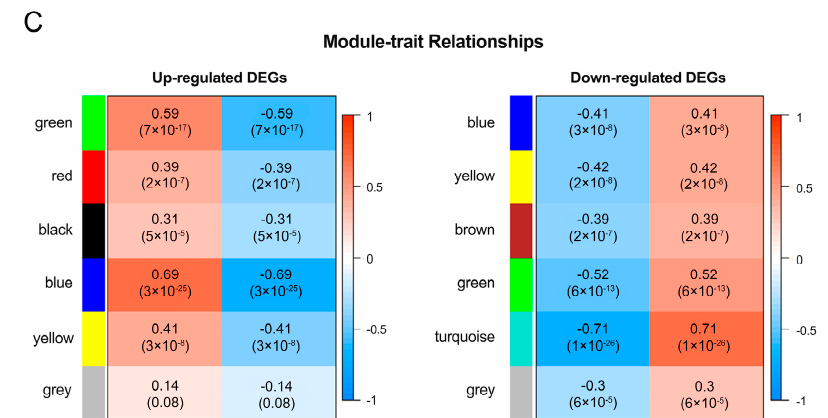
Figure 3. Clustering and module identification between DEcodingRNAs and DEncRNAs using WGCNA. Decision of soft-thresholding powers for scale-free topology ( β ) and mean connectivity ( A ). Hierarchical clustering dendrogram based on the dissimilarity between DEcodingRNAs and DEncRNAs. The first colored rows indicate modules with highly interconnected genes. The second colored rows indicate merged modules with high correlation ( B ). Module-trait relationships are calculated using correlations between module eigengene values and clinical traits. Modules were labeled using correlation coe ffi cients and p values ( C